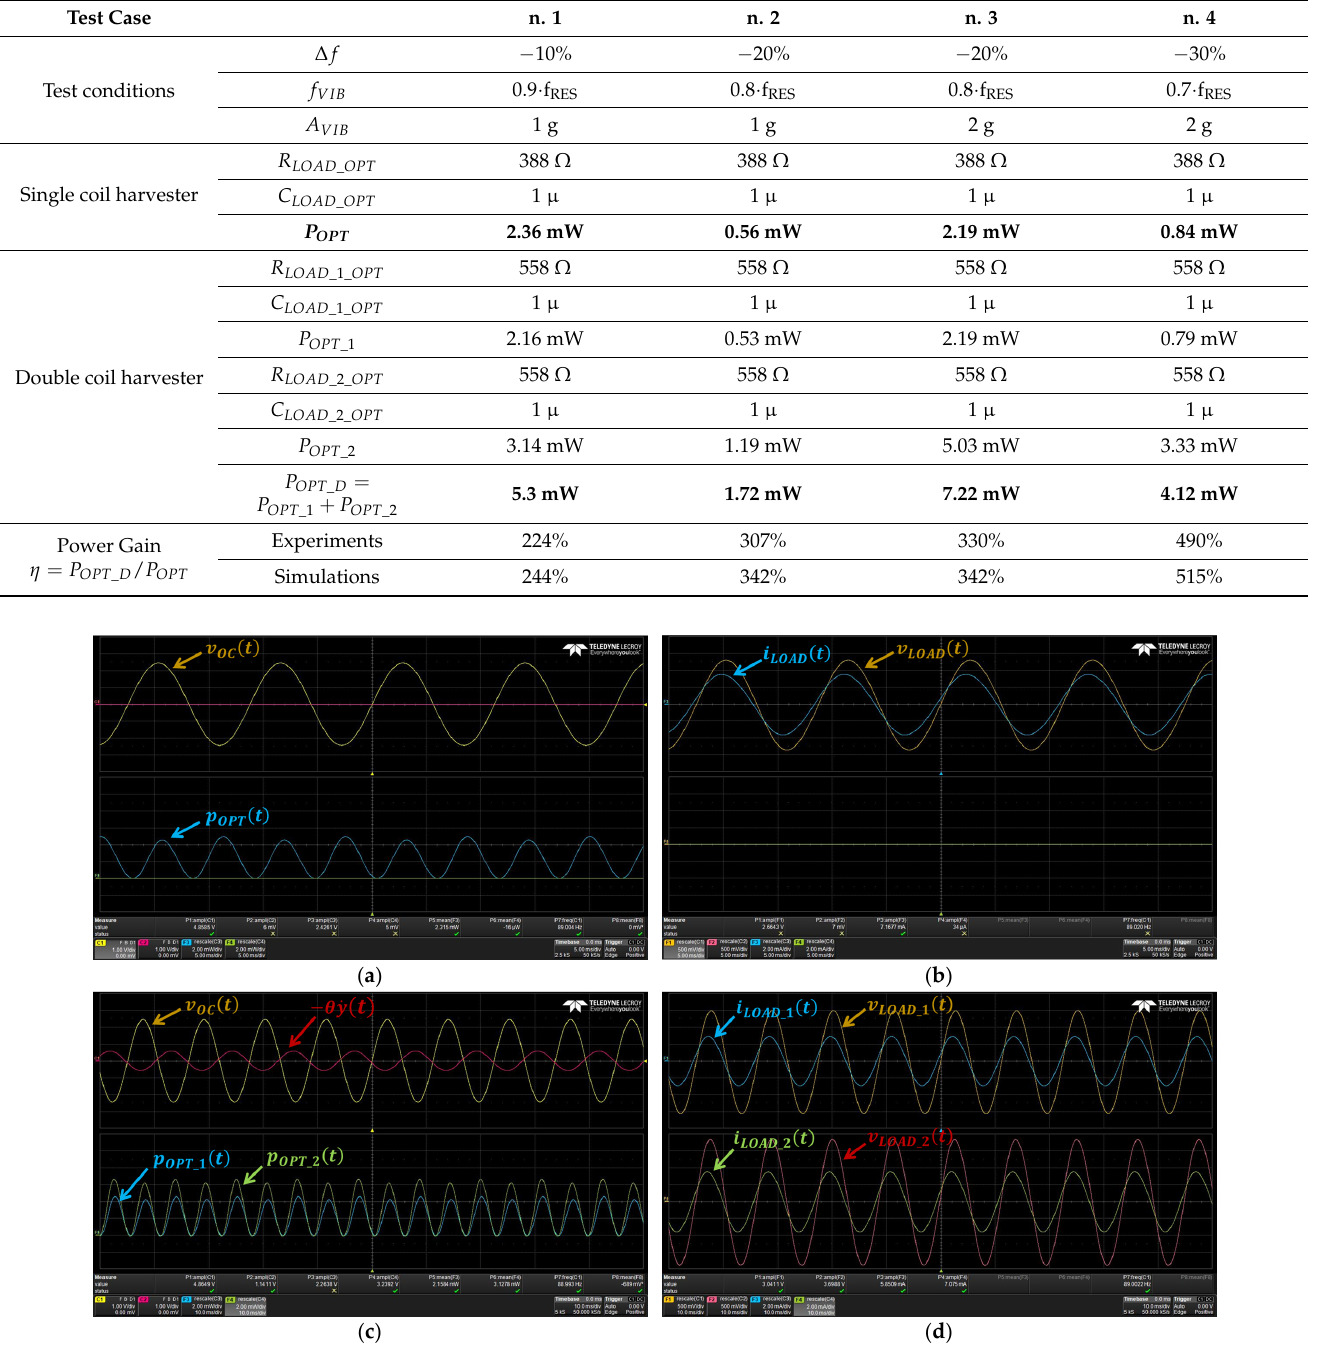
Figure 12. Oscilloscope screenshots obtained in the optimal conditions for the first test case. Test for the single coil circuit in Figure 8: ( a ), input voltage v OC ( t ) (yellow line) and instantaneous load power 𝑝 (cid:3016)(cid:3017)(cid:3021) (𝑡) (blue line); ( b ) load voltage 𝑣 (cid:3013)(cid:3016)(cid:3002)(cid:3005) (𝑡) (yellow line) and load current 𝑖 (cid:3013)(cid:3016)(cid:3002)(cid:3005) (𝑡) (blue line). Test for the double coil circuit in Figure 11a: ( c ) input voltage 𝑣 (cid:3016)(cid:3004) (𝑡) (yellow line), additional voltage 𝜃𝑦(cid:4662)(𝑡) (red line), instantaneous power on the first load 𝑝 (cid:3016)(cid:3017)(cid:3021)_(cid:2869) (𝑡) (blue line), and instantaneous power on the second load p OPT_ 2 ( t ) (green line); ( d ) first load voltage v LOAD_ 1 ( t ) (yellow line), first load current i LOAD_ 1 ( t ) (blue line), second load voltage v LOAD_ 2 ( t ) (red line), and second load curren i LOAD_ 2 ( t ) (green